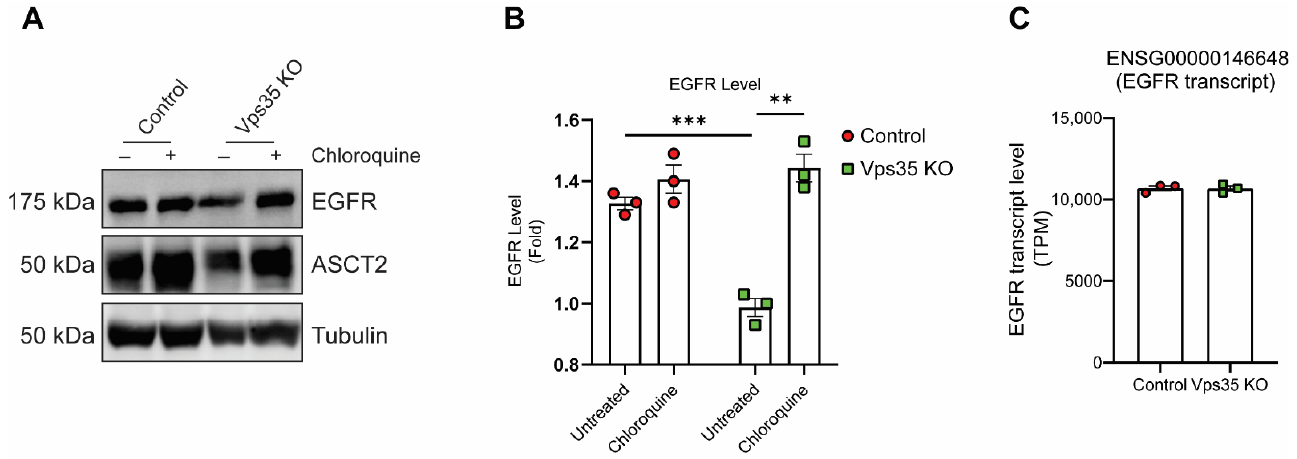
Figure 1. Retromer depletion decreases EGFR levels in HeLa cells. ( A ) Steady-state HeLa control and Vps35 KO cells were treated with 50 µM chloroquine in complete-DMEM media for 16 h. Cells were then harvested and equal amounts of protein samples were subjected for SDS-PAGE and immunoblotting with the antibodies against EGFR and ASCT2, whereas tubulin served as a loading control. Representative blots from three independent experiments are shown. ( B ) The fold differences for EGFR levels are presented (means ± SEM). Two-tailed student’s t -test indicated the difference between HeLa control and Vps35 KO cells, *** p < 0.001, HeLa control vs. Vps35 KO (untreated); ** p < 0.01, Vps35 KO (untreated) vs. Vps35 KO (chloroquine). ( C ) EGFR transcript levels between HeLa control and Vps35 KO cells were measured by RNA-Seq analysis from three replicate samples as represented by Transcripts Per Million (TPM).